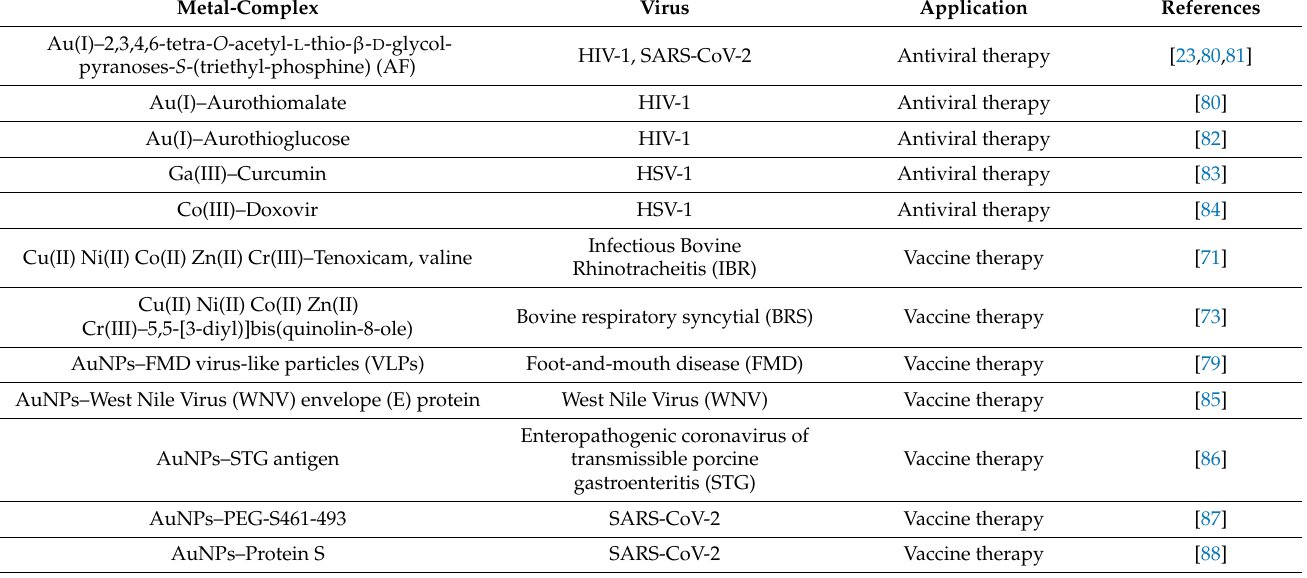
Table 1. Comprehensive list of antiviral